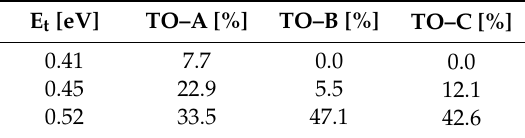
Table 2. Energy Levels E t measured of TSC components measured in the range 290-400 K. Trap occupancy TO measured for each energy level depending on the different filling processes at room temperature, A: long term storage; B: filling time 230 s; C: filling time 640 s.